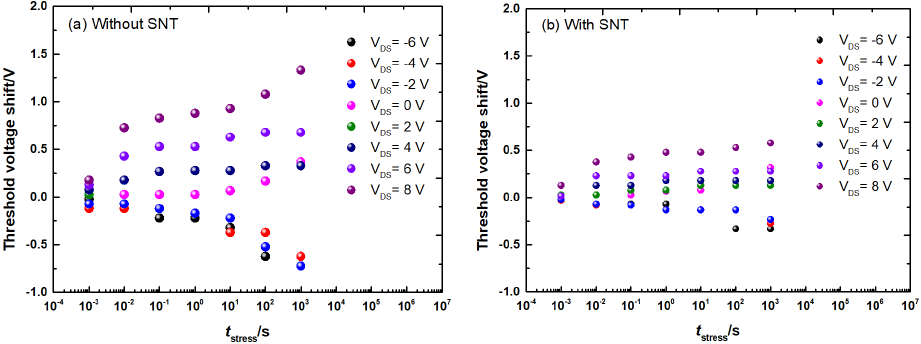
Figure 6. Stress − sequence of the all-GaN integrated MIS-HEMTs ( a ) without SNT and ( b ) with